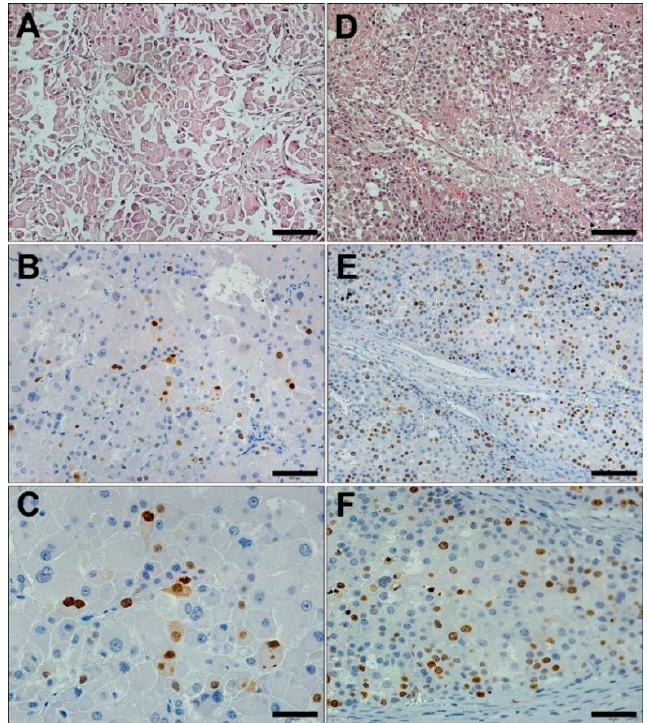
Figure 4. Ki-67 immunohistochemistry in ACC. Low magnification (20 × ) images shown in A and D depict HE staining of ACC. Low Ki-67 immunostaining is shown in B (20 × ) and C (40 × ). High Ki-67 expression is shown in E (20 × ) and F (40 × ). Scale bar: A, D, B, and E = 100 µm; C and F = 50 µm.